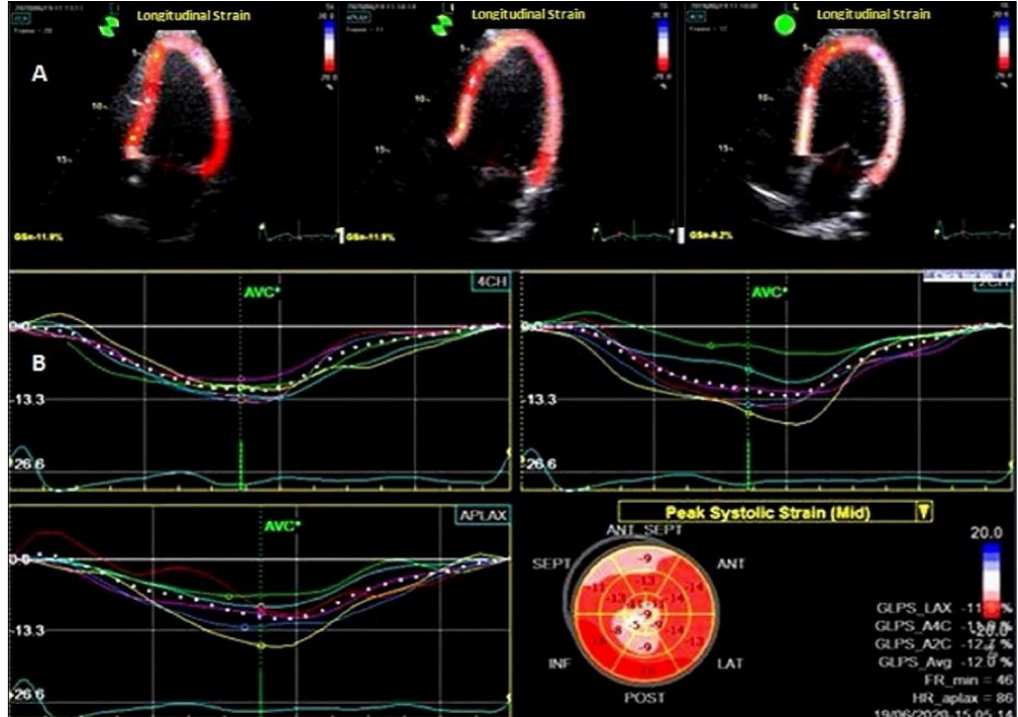
Figure 2. Left ventricular two-dimensional speckle tracking echocardiography. ( A ) Apical 2, 3, and 4 chamber incidences longitudinal strain analysis; ( B ) Bull’s eye synopsis.